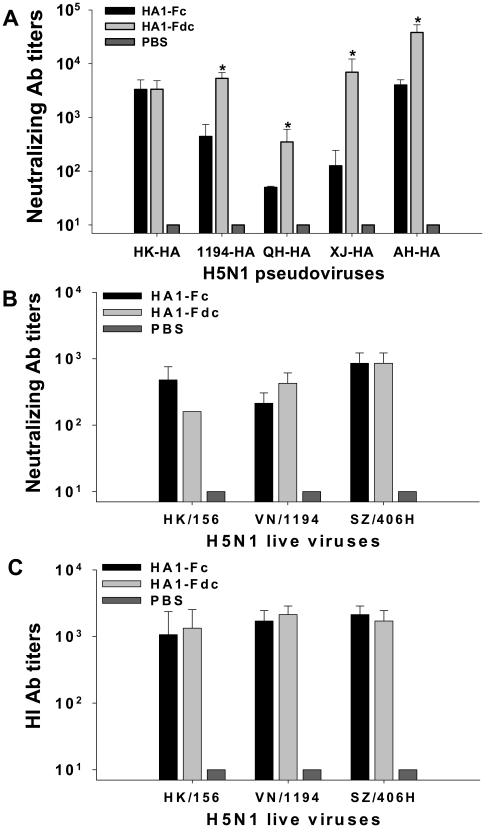
Assessment of neutralizing antibody and HI antibody titers in HA1-Fc- and HA1-Fdc-vaccinated mouse sera.Sera were collected at 10 days post-last vaccination. PBS was used as the negative control. (A) Neutralizing antibody titers against HA of heterologous (HK-HA, 1194-HA, QH-HA and XJ-HA) and homologous (AH-HA) strains of H5N1 pseudovirus. The data are presented as mean 50% neutralizing antibody titer (NT50) ±SD from five mice per group. * indicates significant difference (P<0.05) between HA1-Fc and HA1-Fdc vaccination groups. (B) Neutralizing antibody titers against heterologous strains (HK/156, VN/1194 and SZ/406H) of H5N1 live virus. The titers of neutralizing antibodies were determined as in Materials and Methods, and are presented as mean NT50±SD of five mice per group. (C) HI antibody titers against heterologous strains (HK/156, VN/1194 and SZ/406H) of H5N1 live virus. The HI titers were determined as the highest serum dilution indicating hemagglutinating activity, and are expressed as mean ± SD of five mice per group.